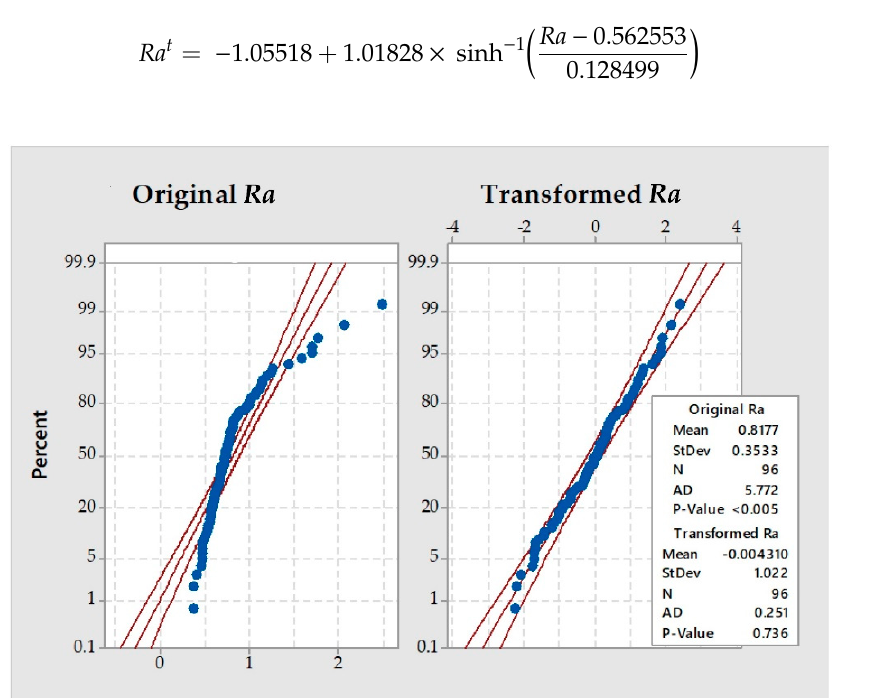
Figure 5. Probability plots of original non-normal data and Johnson transformed data of the Ra .